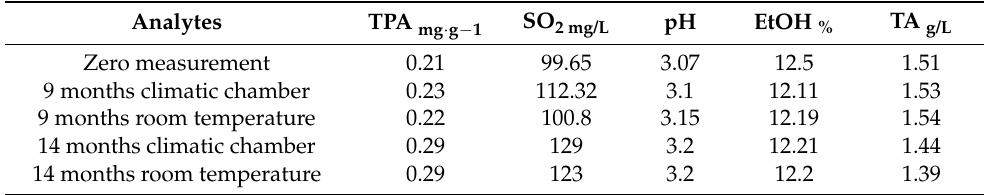
Table 9. Basic oenological parameters. Biologically active substances. Cabernet Sauvignon ros é . Basic oenological parameters . Sample D—Cabernet Sauvignon ros é , harvest 2016.